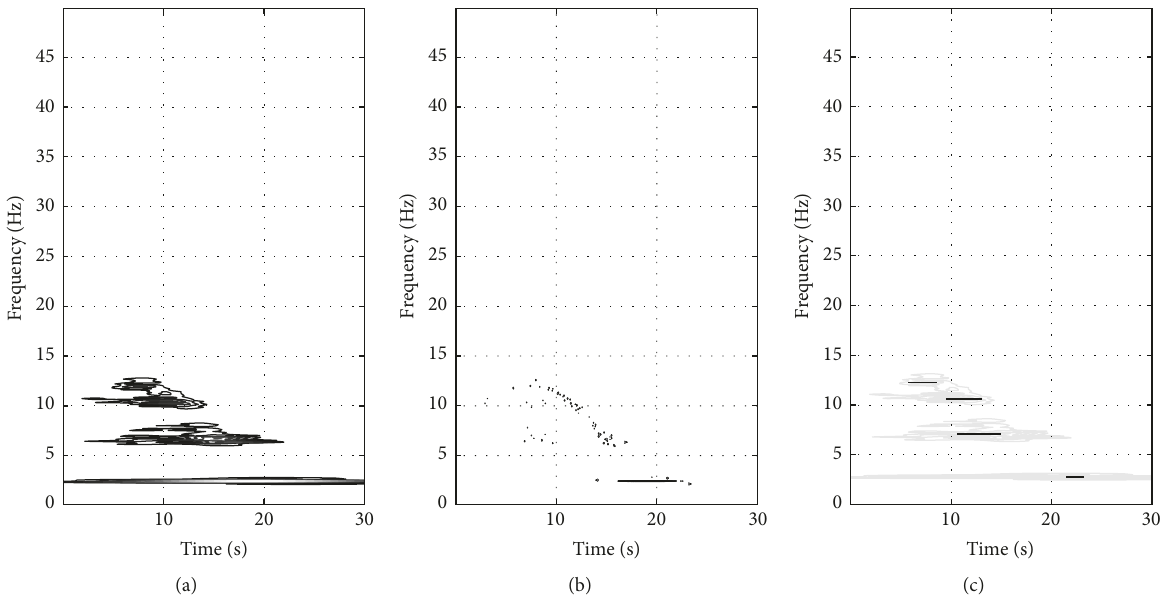
Figure 10: Morlet scalogram (a), Morlet reassigned scalogram (b), and detected features (c).